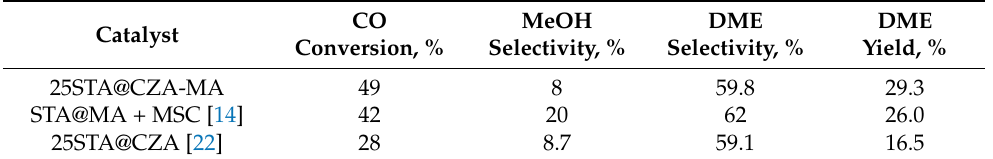
Table 3. The comparison of Activity Test Results of the STA incorporated bifunctional